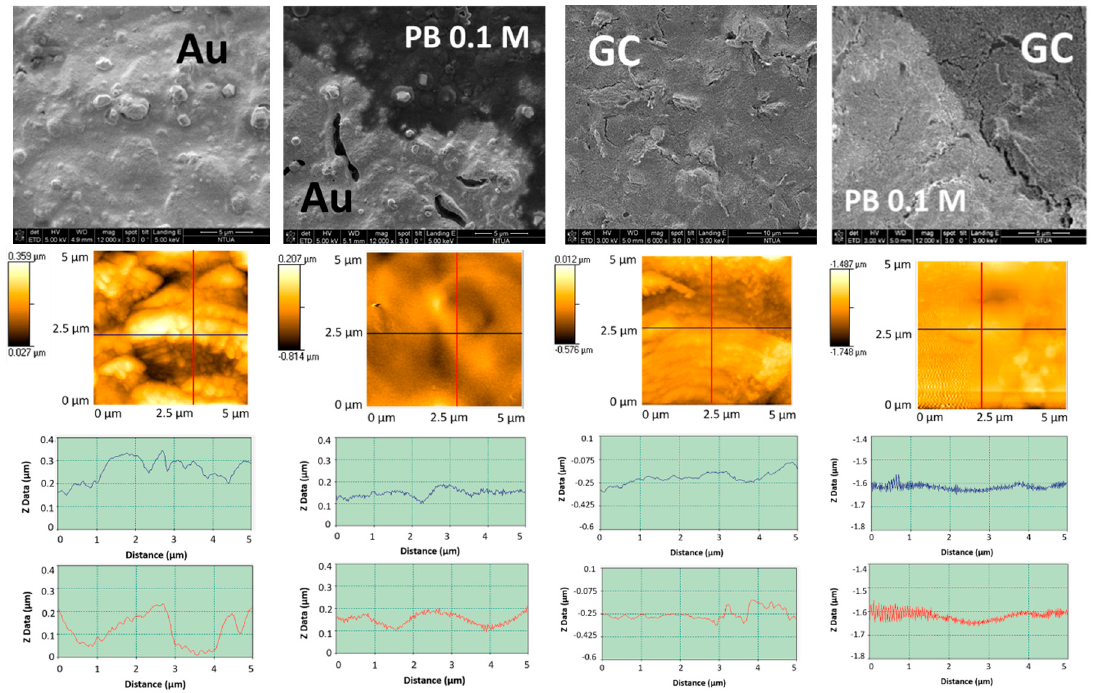
Figure 10. First row: SEM of Au and glassy carbon (GC) SPEs before and after LIFT treatment with phosphate buffer 0.1 M. Second row: corresponding atomic force microscopy (AFM) topographic images recorded in contact mode; third row: roughness profiles in the two orthogonal directions indicated in the AFM images.